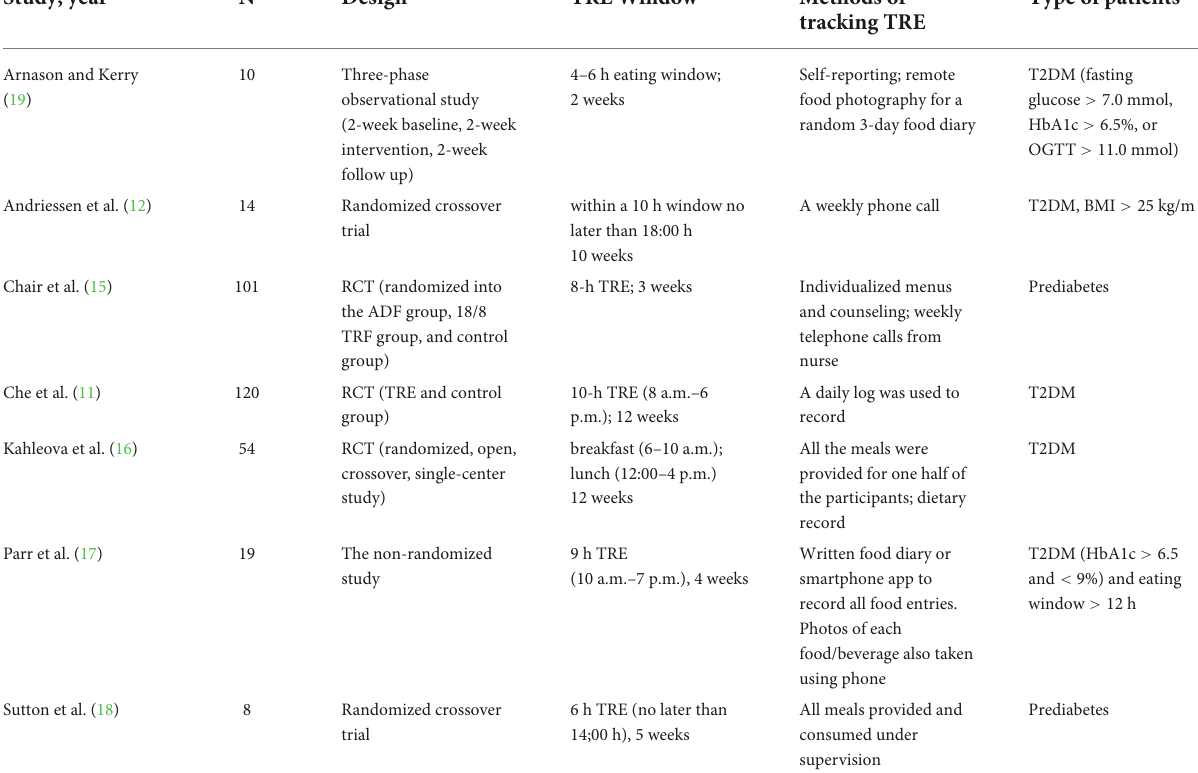
TABLE 1 The characteristics of studies.